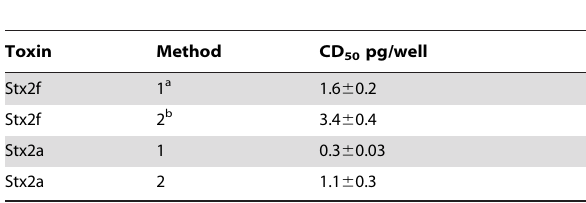
Table 2. Purification yields from each of the four steps in Stx2f purification, as measured by CD 50 .